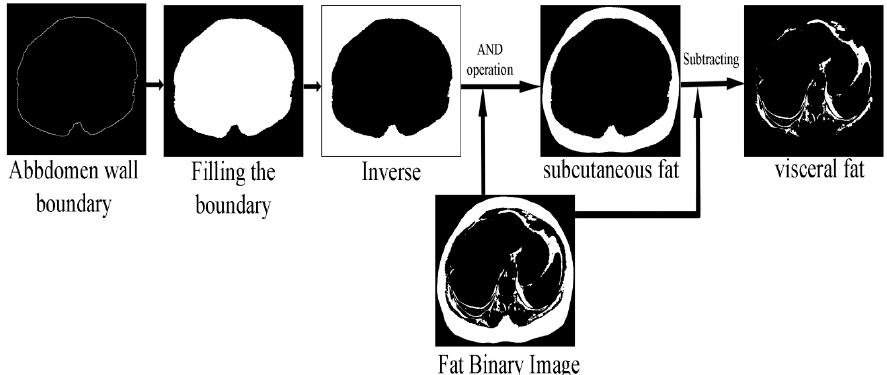
Figure 9. SF and VF classification operation.